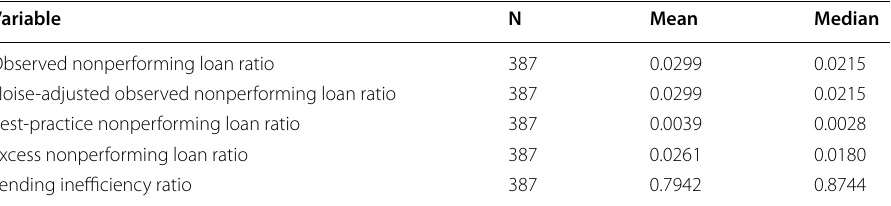
The data set includes LendingClub and 387 top-tier bank holding companies at the end of 2016 with plausible values of nonperforming unsecured consumer loans and total loans exceeding 10 percent of assets Skewness and D’Agostino skewness test of OLS residuals ( ∼ N ( 0,1 ) asymptotically ) : skewness = 4.7992 (> 0 ) ⇒ positively skewed test statistic = 16.7911 with p -value < 2.2E 16 ⇒ positively skewed with statistical significance. − Histogram and density of OLS residuals in the relative frequency scale appear in Appendix 1 16 ⇒ strongly reject linear regression model (i.e., absence of inefficiency) in favor − of stochastic frontier model (i.e., presence of inefficiency) Table 2 2016 Unsecured consumer loans. Including the volume of unsecured consumer lending. Summary statistics of nonperformance derived from stochastic frontier estimation